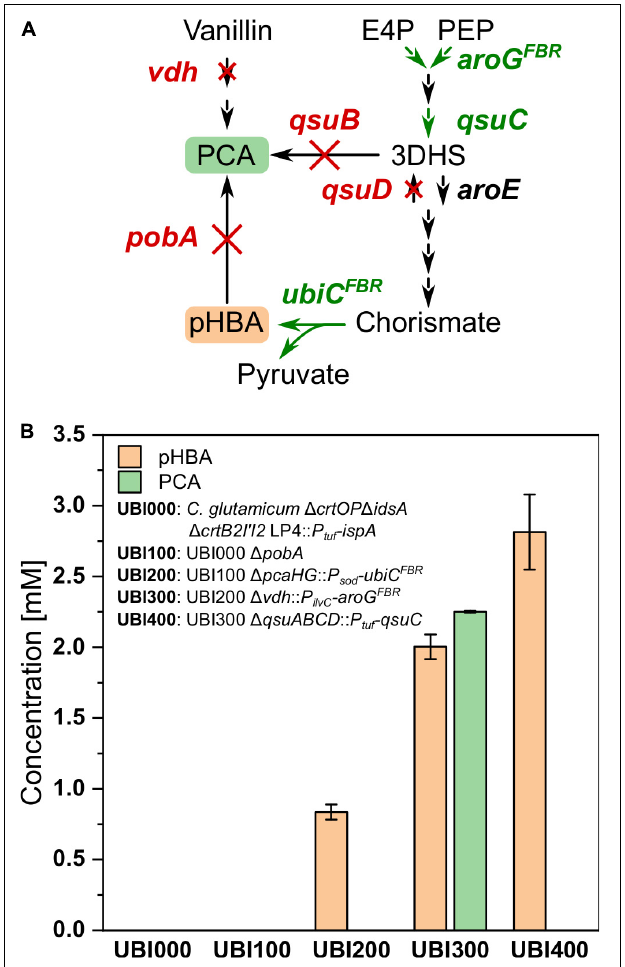
FIGURE 4 | Production of pHBA from consecutively constructed UBI strains. (A) Pathway from the intermediates E4P and PEP toward pHBA and PCA with deleted genes shown in red and chromosomal overexpression of genes shown in green. (B) Production of pHBA and the side product PCA after 24 h of cultivation. E4P, erythrose 4-phosphate; PEP, phosphoenolpyruvate; 3DHS, 3-dehydroshikimic acid; PCA, protocatechuic acid; pHBA, para -hydroxybenzoic acid; aroG FBR , feedback-resistant DAHP synthase from E. coli ; qsuC , 3-dehydroquinate dehydratase; qsuB , 3-dehydroshikimate dehydratase; qsuD , shikimate dehydrogenase; aroE , shikimate dehydrogenase; ubiC FBR , feedback-resistant chorismate-pyruvate lyase from E. coli ; pobA , para -hydroxybenzoate hydroxylase; vdh , vanillin dehydrogenase. Values and error bars represent means and standard deviations ( n =